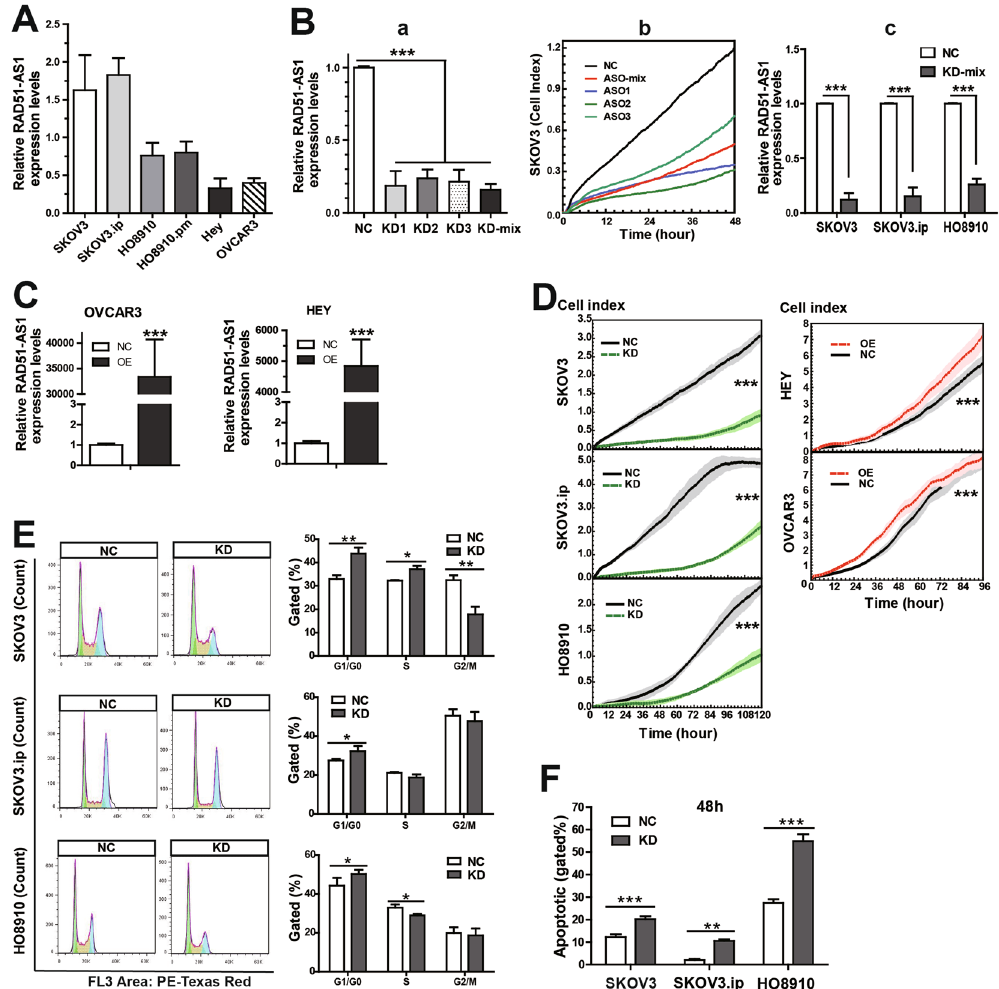
Figure 2. Study of the biological and functional characteristics of RAD51-AS1 in vitro . ( A ), Relative RAD51-AS1 expression in EOC cell lines. ( B ), a,b: QRT-PCR and proliferation assay to quantify the silencing efficiencies of RAD51-AS1 in SKOV3 cells transfected with ASO1, ASO2, ASO3 and ASO-mix. c: QRT- PCR confirmed that RAD51-AS1 was efficiently silenced by transfection with ASO-mix in SKOV3, SKOV3. ip and HO8910 cells. ( C ), The efficiency of RAD51-AS1 overexpression was confirmed by qRT-PCR ( D ), Proliferation assays. Cell growth curves were automatically recorded in real-time. Silencing of RAD51-AS1 inhibited cell proliferation in SKOV3, SKOV3.ip and HO8910 cells. Overexpression of RAD51-AS1 increased the proliferation of Hey and OVCAR3 cells. The light-colored error bars denote the SD. ( E ), Cell cycle assays. RAD51-AS1 knockdown increased the percentage of cells in G1/G0 phase, while the effects on S and G2/M phages are not consistent among the 3 cell lines. ( F ), Apoptosis assays. RAD51-AS1 knockdown increased the percentage of apoptotic cells in SKOV3, SKOV3.ip and HO8910 cells. Each experiment was repeated in triplicate (n = 3). KD, knockdown of RAD51-AS1 expression. OE, overexpression of RAD51-AS1, NC, negative control. (The results are shown as the mean ± SD; * P < 0.05; ** P < 0.01; *** P < 0.001 by Student’s t